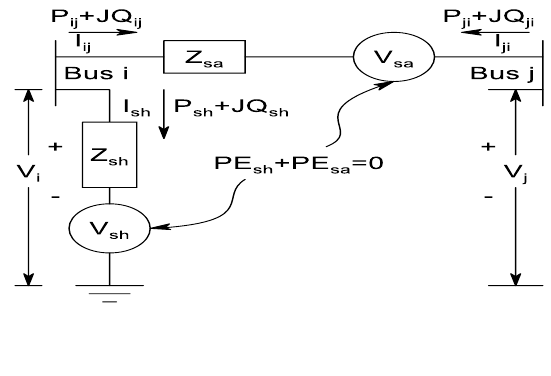
Figure 2. UPFC-Power injection